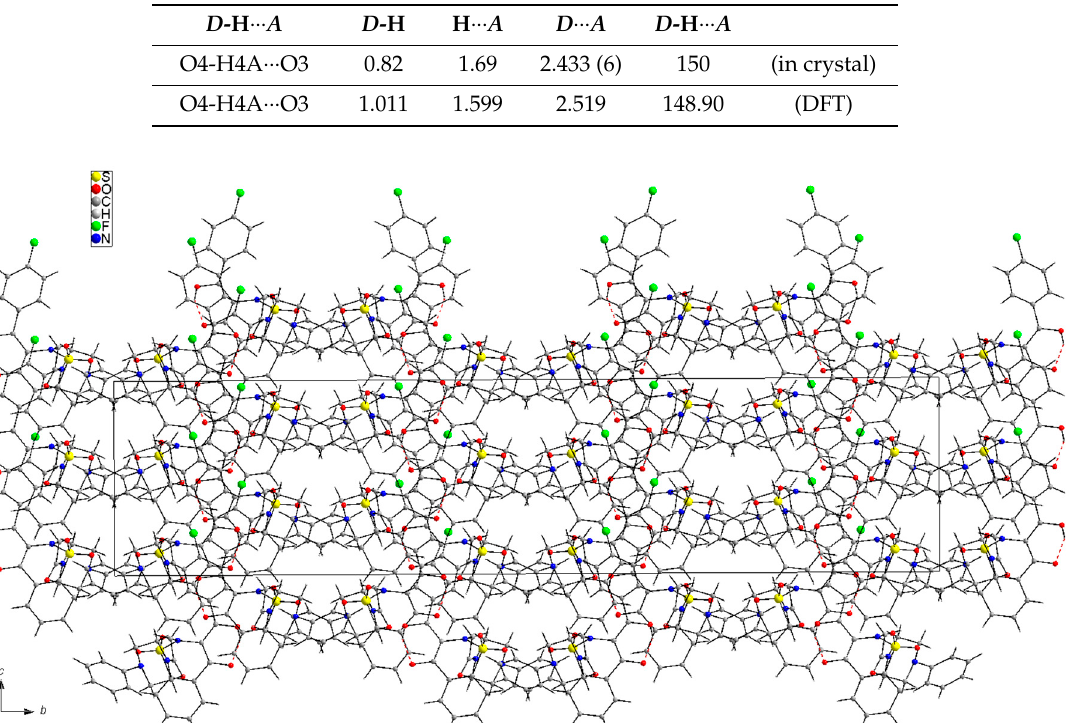
Table 3. Hydrogen-bond geometry (Å, ◦ ).